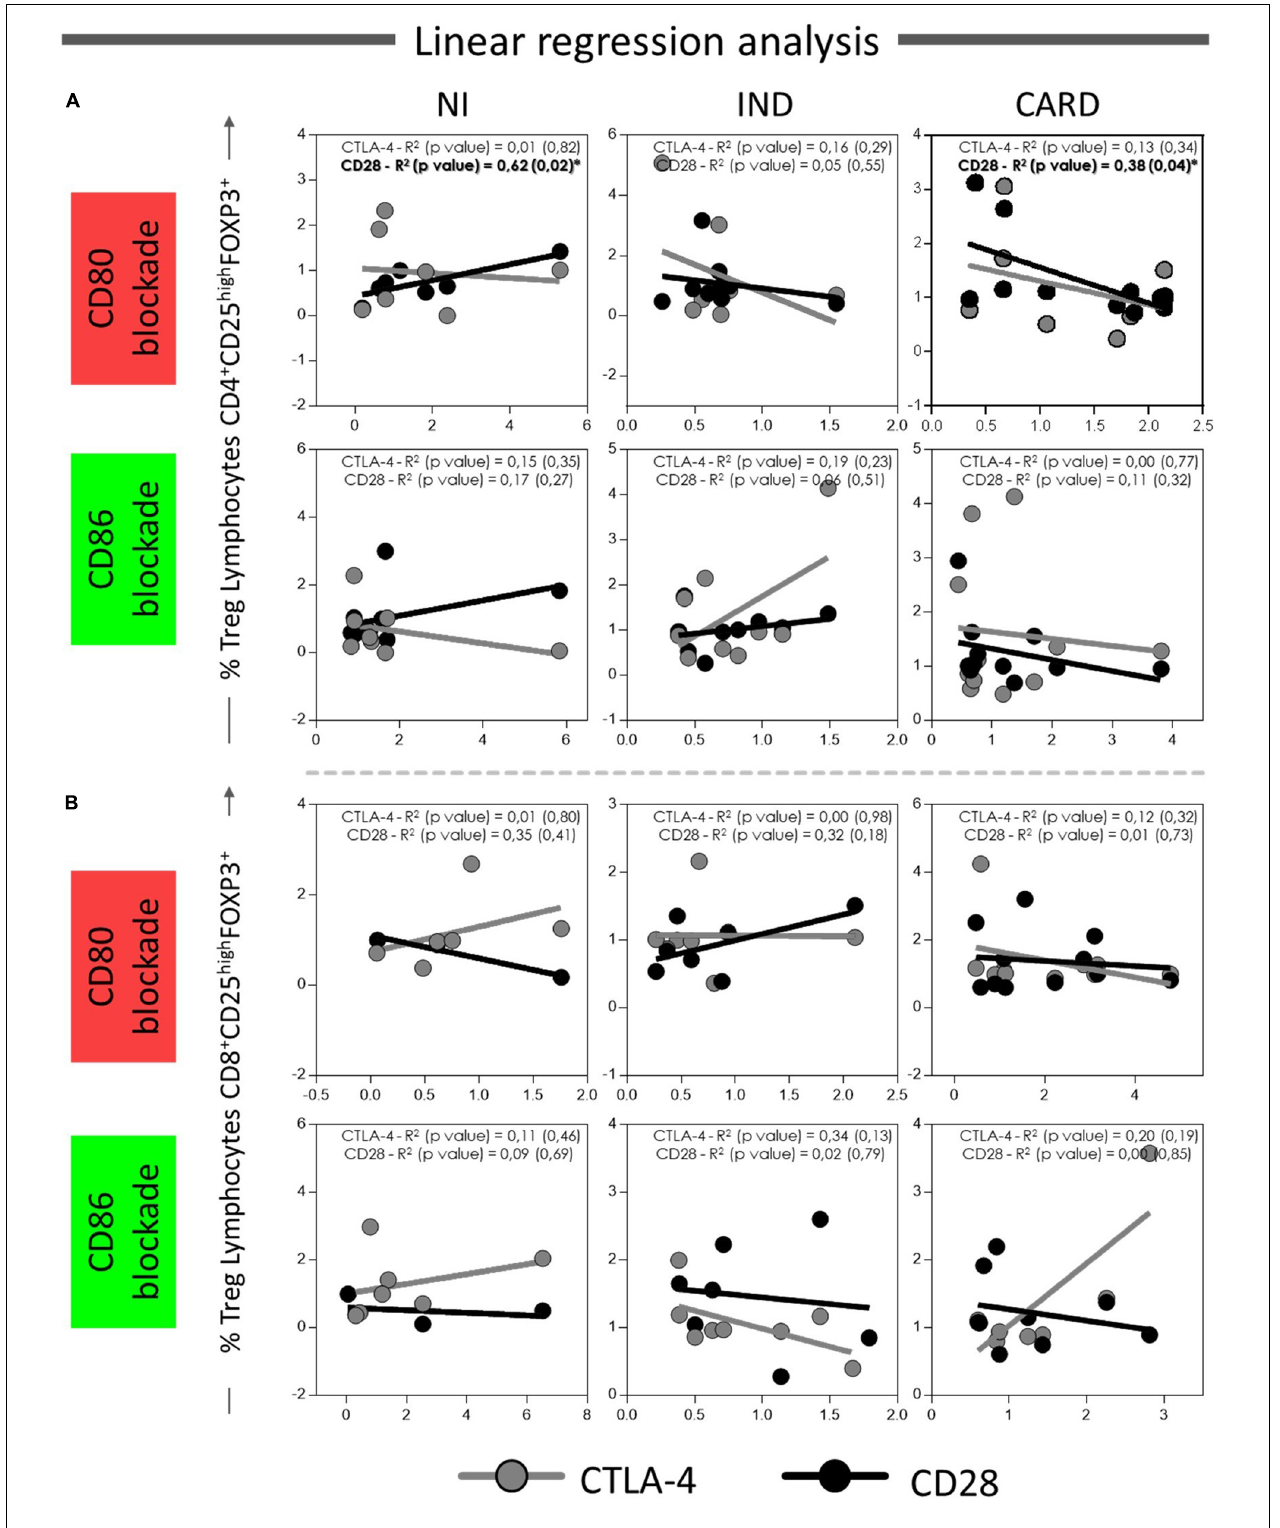
FIGURE 7 | Linear regression analysis between CD4 + and CD8 + Treg lymphocytes and CD28 and CTLA4 ligands on Treg lymphocytes. Association between CD4 + Treg lymphocytes (A) and CD8 + Treg lymphocytes (B) with CD28 and CTLA-4 expressed in CD4 + and CD8 + Treg cells from PBMC culture of NI individuals ( n = 9), indeterminate (IND, n = 9), and cardiac (CARD, n = 11) clinical forms of Chagas disease, after in vitro stimulation with T. cruzi antigens and anti-CD80 and anti-CD86 antibody blockade. Data are presented by R-squared (R 2 ), and significant statistical differences were considered when p < 0.05.